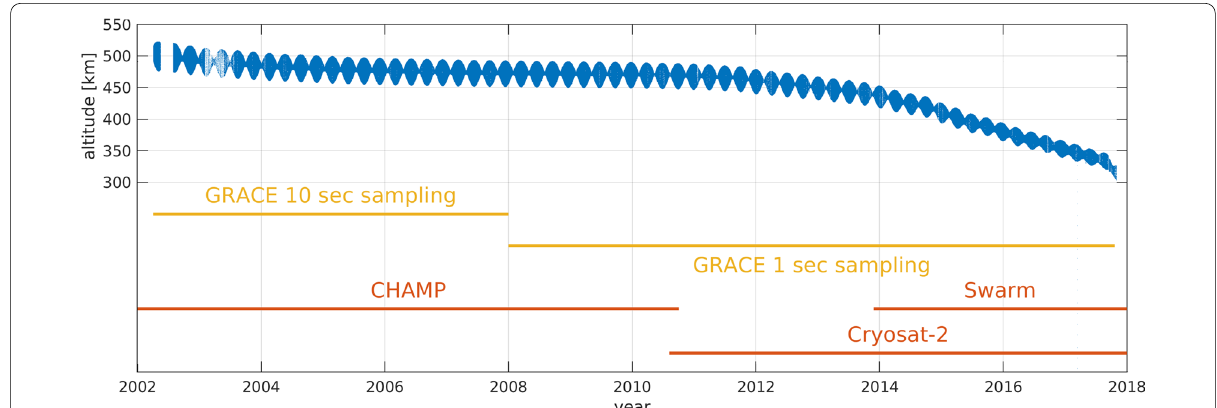
6371.2 km. Orange and red lines show data availability for GRACE and other